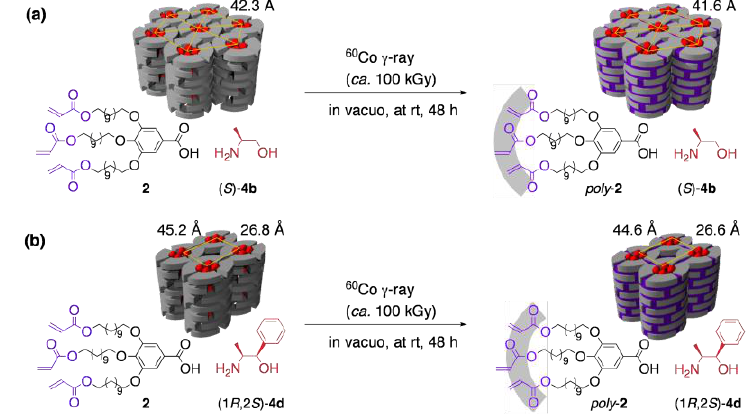
Figure 4. In situ cross-linking of two-component LCs with ( a ) hexagonal and ( b ) rectangular columnar structures.